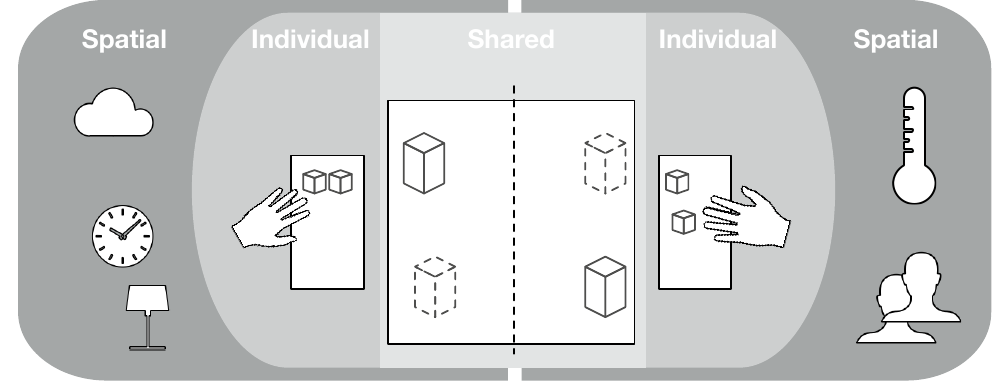
Figure 4. Different shared and individual interactional spaces within an ecosystem of physical and digital